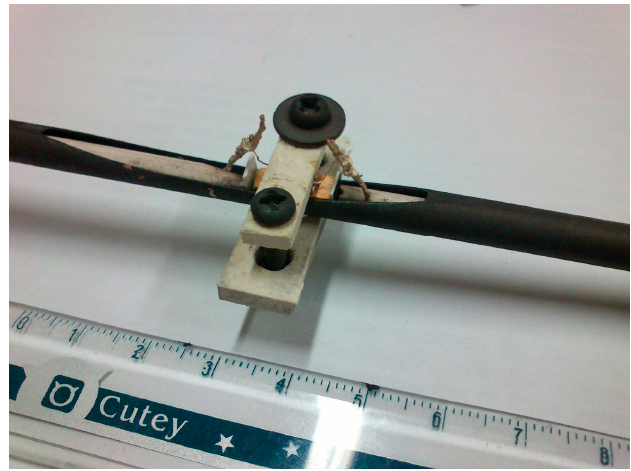
Figure 10. Schematic diagram and picture of the arrangement of the 4-probe DC method and tooling for ionic conductivity measurement. LSCF-6428, (La 0.6 Sr 0.4 )(Co 0.2 Fe 0.8 )O 3 ; 8YSZ, 8 mol% yttria-stabilized zirconia.